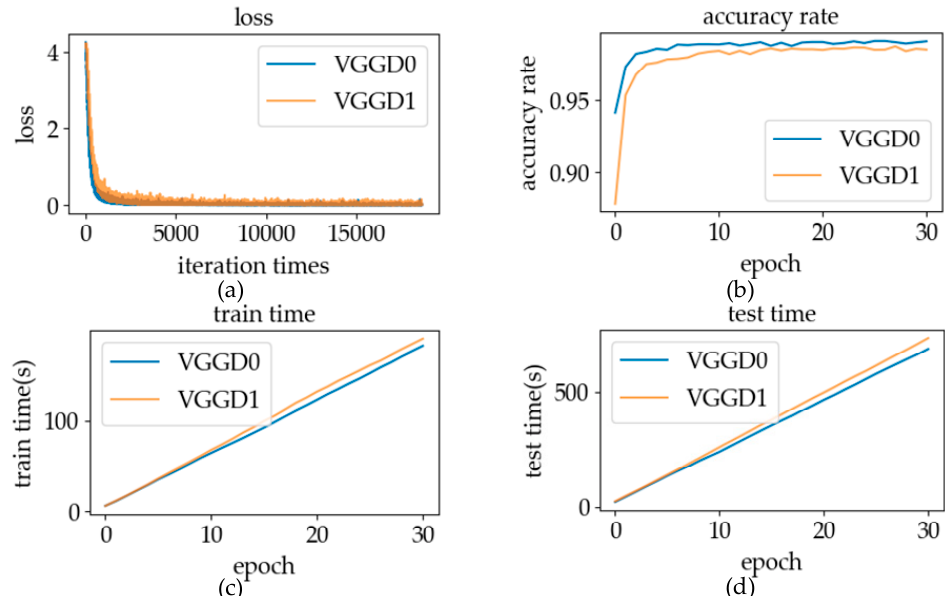
Figure 18. The experimental results for the adaptive average pooling layer. ( a ) The change curve of loss with iterations. ( b ) The change curve of the accuracy rate with epoch. ( c ) The change curve of training time with epoch. ( d ) The change curve of test time with epoch. The VGGD1 represents the situations without an adaptive average pooling layer and the VGGD0 represents the situations after using an adaptive average pooling layer.